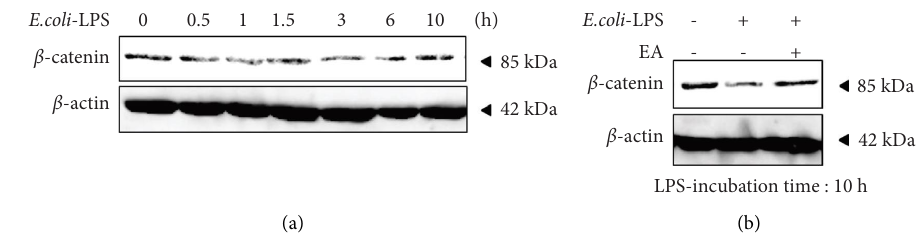
Figure 5: Efects of EA on the LPS induced downregulation of Wnt/ β -catenin signaling in ST2. (a) E. coli -LPS (1 μ g/mL) is applied to ST2 cells and collected at several time points. β -Catenin in ST2 cells is analyzed by Western blotting. β -actin is used as a loading control. (b) E . coli -LPS (1 μ g/mL) and/or EA; Equisetum arvense extract (3 μ g/mL) are treated in ST2 cells for 10 hours on ST2 cells. β -Catenin in ST2 cells is analyzed by Western blotting. β -actin is used as the loading